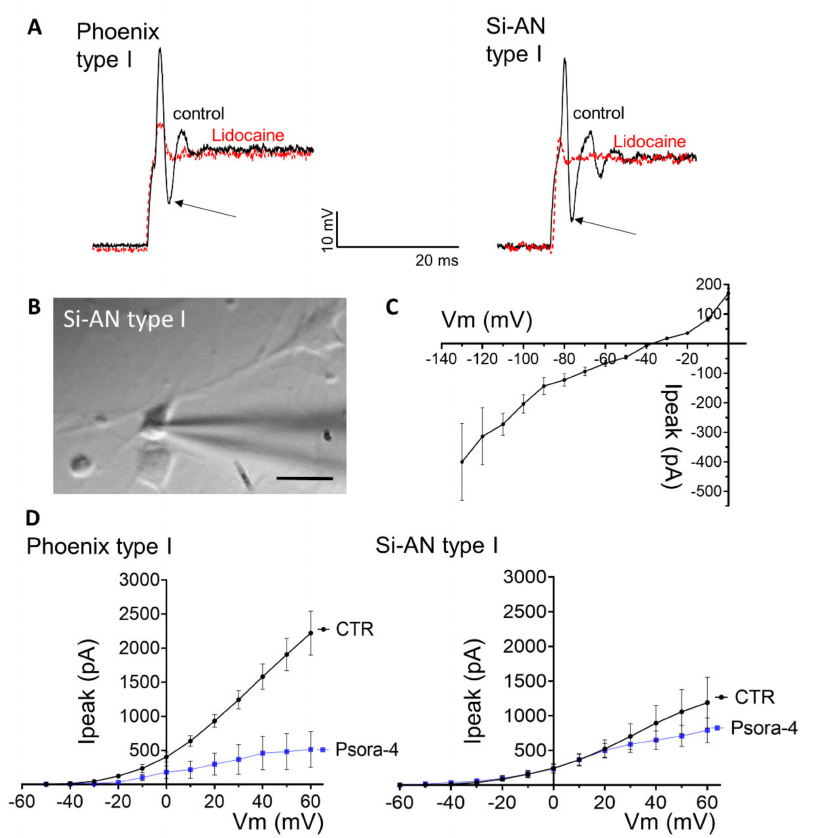
Figure 7. Differentiated phoenix and si-ANs cells functionally and morphologically resemble primary type I spiral ganglion neurons (SGNs). ( A ) Type I phoenix and si-ANs cells show similar rapidly adapting action potentials with a pronounced sag current (arrows) that are effectively blocked by lidocaine (10 nM). ( B ) Morphologically, si-ANs and phoenix type I cells resemble primary type I SGNs. Scale bar 10 µ m. ( C ) Voltage–current relationship of HCN channels that are abundantly expressed in type I phoenix and si-ANs cells, leading to a rapid hyperpolarization after the action potential (arrows in A). ( D ) si-ANs and phoenix cells are able to generate large delayed rectifier potassium currents, partially carried by Kv1.3 as block with the specific inhibitor Psora-4 indicates. Psora-4. Shown are voltage–current